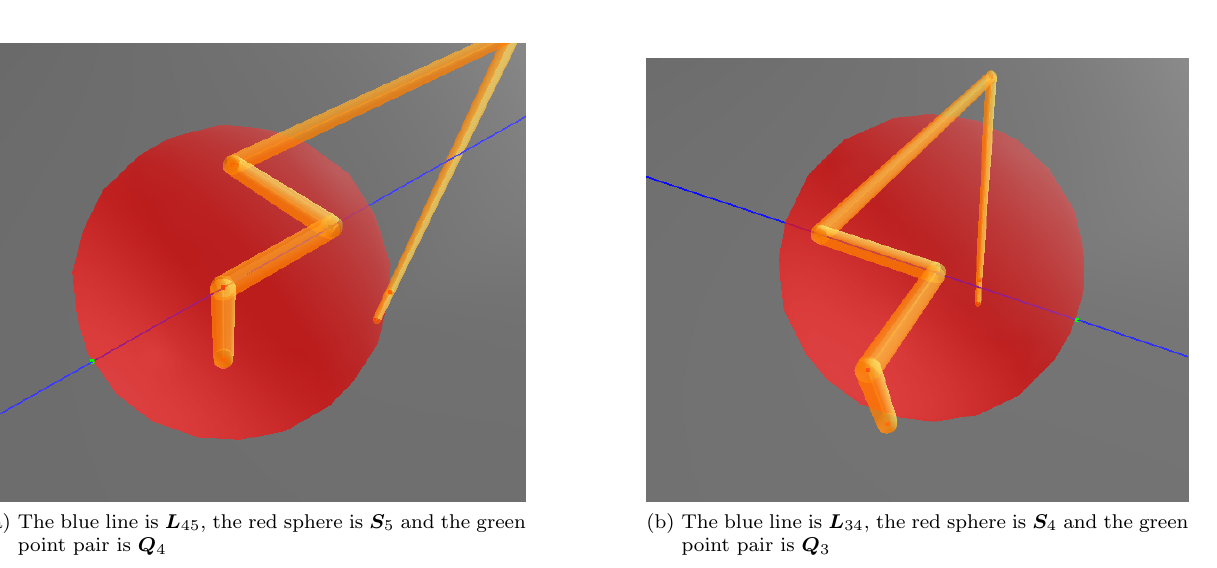
Figure 9: Figures showing the process of finding P 3 and P 4